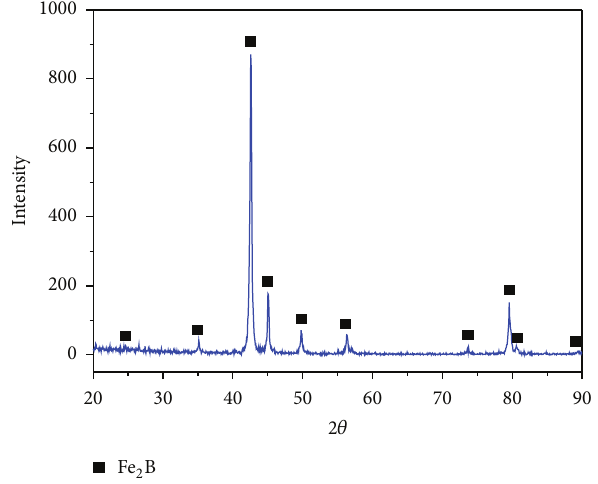
Figure 3: X-ray diffraction patterns of GCI boronized at 1223 K for 8